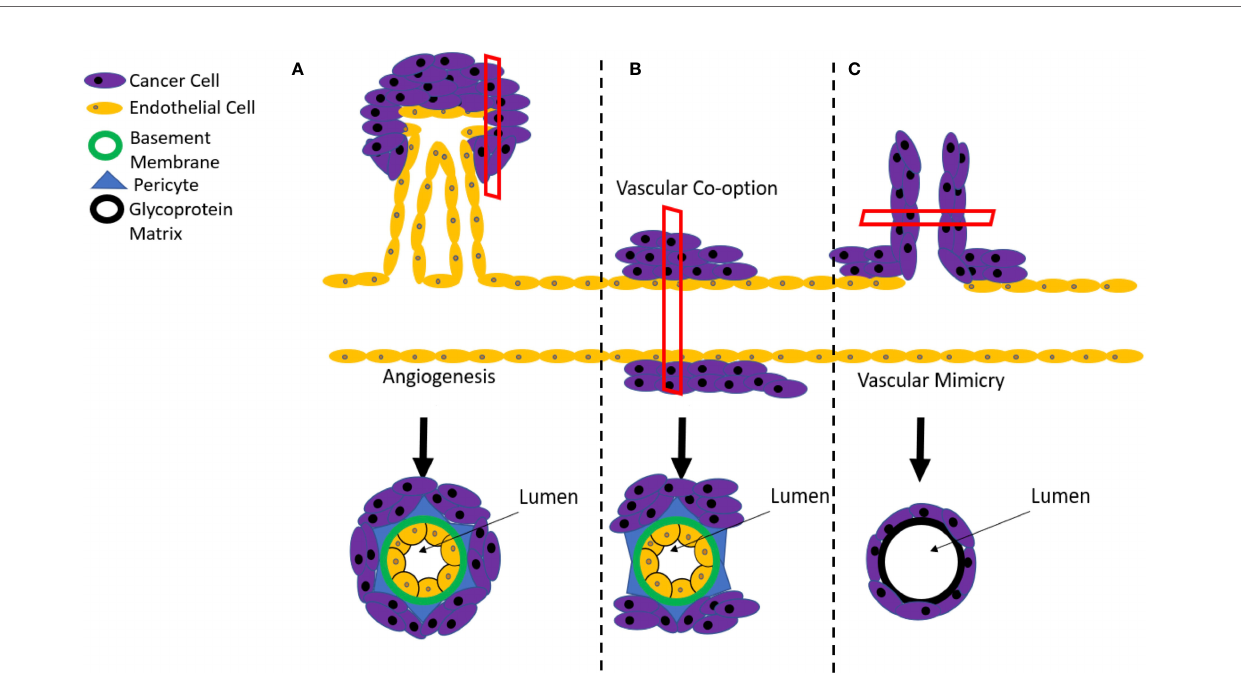
FIGURE 1 | Mechanisms of tumor angiogenesis. (A) Tumor vascularization typically occurs by sprouting angiogenesis, involving the generation of new vessels via sprouting from the pre-existing circulation. However, resistance mechanisms to anti-angiogenic therapies can include (B) vascular co-option, where the tumor grows along existing vessels or (C) vascular mimicry where cancer stem cells create a de novo